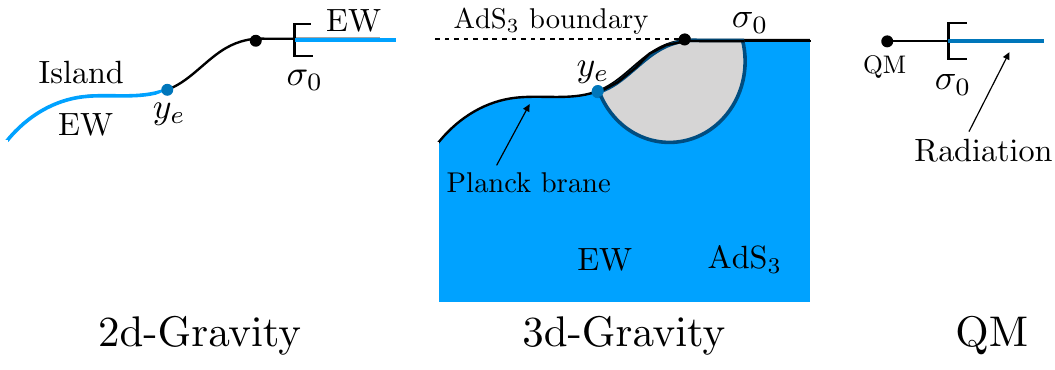
Figure 6 . The analog of (cid:12)gure 4 for the late time entanglement wedge of the radiation . The rightmost picture depicts the interval whose entropy is being considered. The leftmost picture depicts (cid:6) Late in the 2d gravity picture. There is an entanglement island, disconnected from the region where the radiation lives. The middle picture depicts the 3d version, the blue region being the entanglement